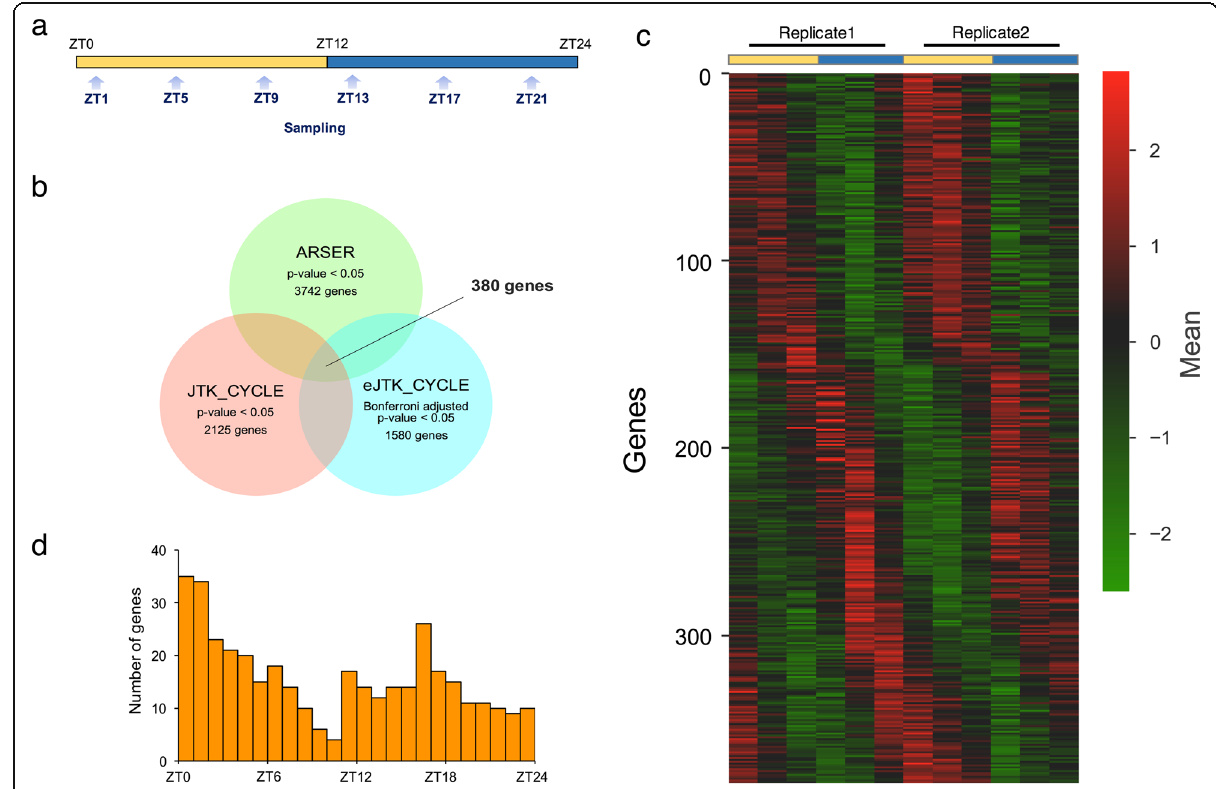
Fig. 3 Diel cycle genes in hydras a Experimental design for microarray analysis. Hydras were collected every 4 h under LD 12:12 cycles. b Detection of diel cycle genes by three algorithms. P values were used for the ARSER and JTK_CYCLE algorithms as cutoff thresholds, while Bonferroni-adjusted P values were used for the empirical JTK_CYCLE algorithm. The 380 genes identified by all three algorithms were defined as Hy DCGs. c Phase-sorted heat map of Hy DCGs. The data for each gene were normalized so that the mean signal intensity for 12 time points and the standard deviation were 0.0 and 1.0, respectively. d Distribution of Hy DCGs across phases for a single cosine model